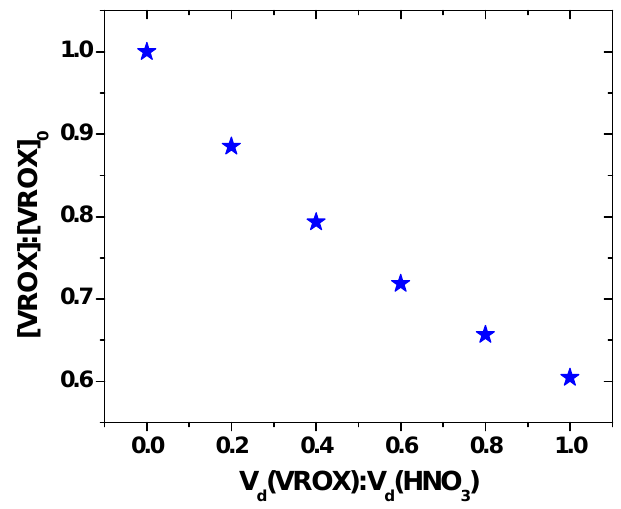
Fig. 6. Influence of deposition on modeled VROX concentrations. The VROX deposition velocity ( V d ) is given as a ratio to that of nitric acid, which represents the “aerodynamic limit” for deposi- tion. VROX concentrations represent an average over the canopy and are normalized to the concentration for the case with no depo- sition